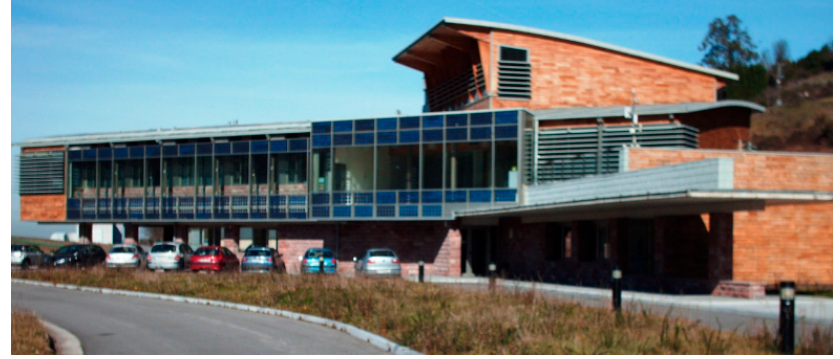
Figure 1. Demonstration container with attached sunspace (south side) located at San Pedro de Anes, Asturias (northern Spain).